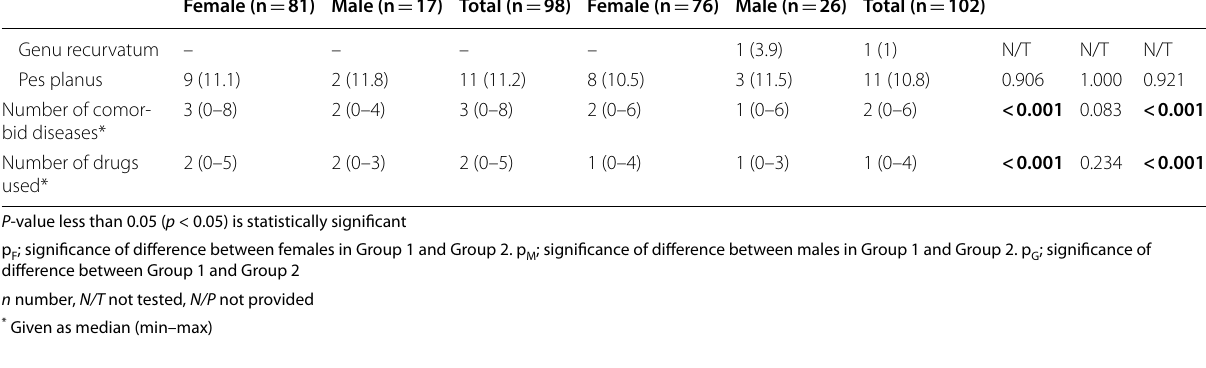
Table 2 Anthropometric measurements and body composition of the study groups